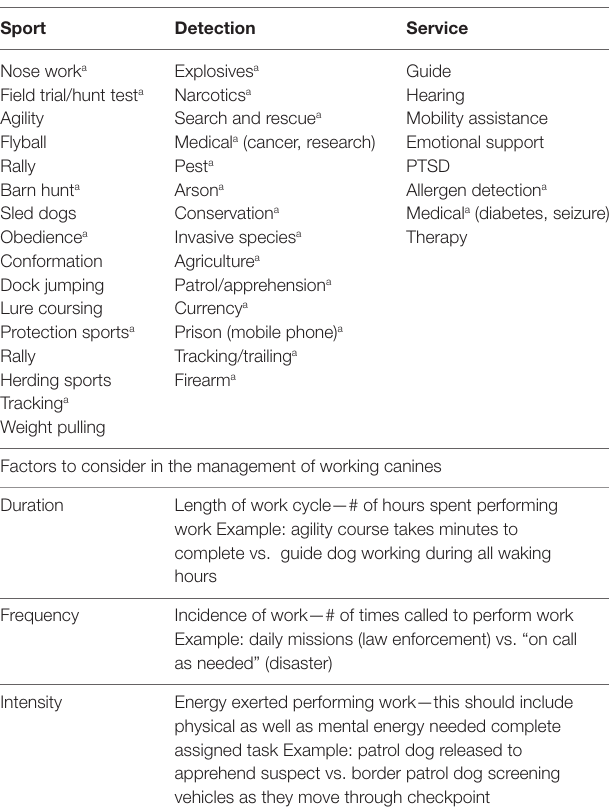
TABLe 1 | Categories of working canines and typical disciplines associated with